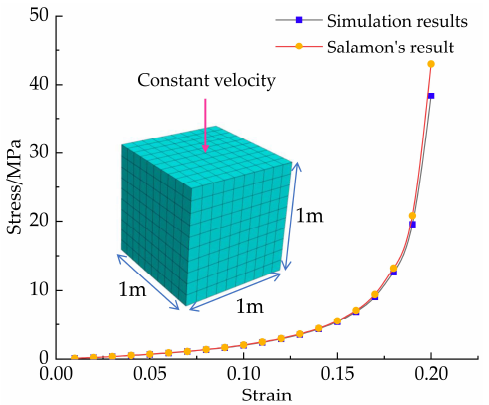
Figure 7. Numerical simulation inversion of goaf parameters.